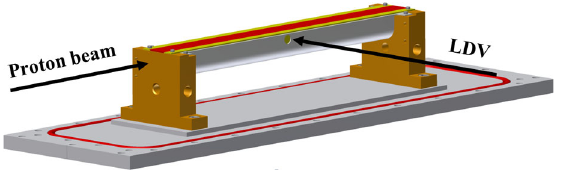
FIG. 3. Tungsten powder trough.